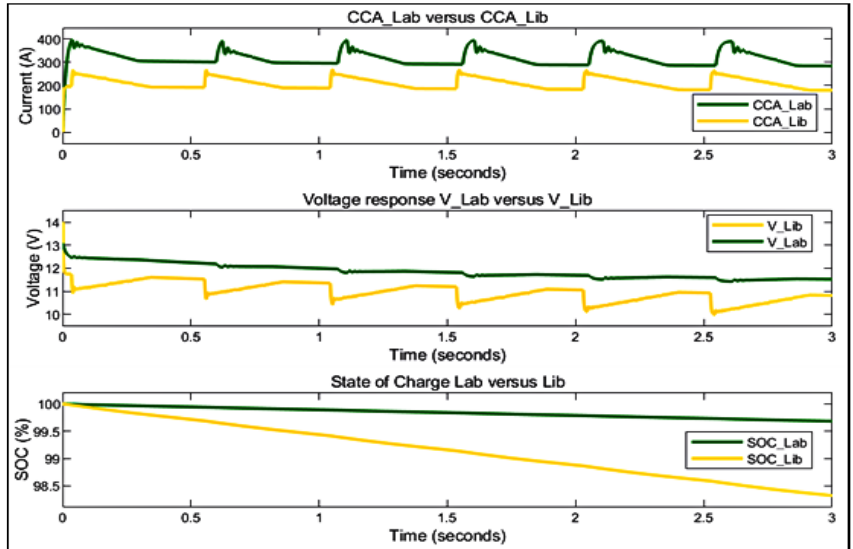
Figure 18. The supplied required CCC, SoC and voltage response of HESS for case three (a) during discharge mode.